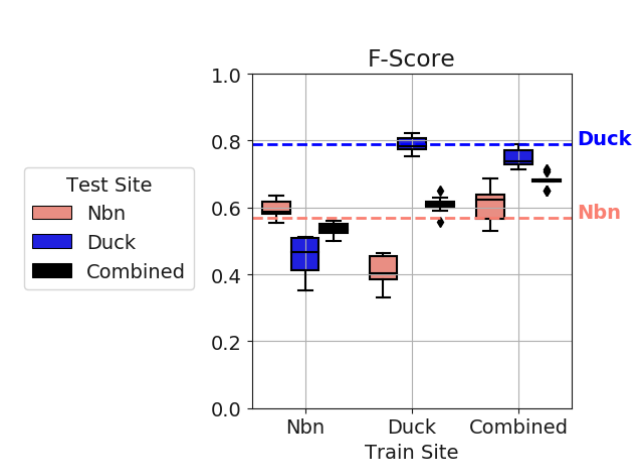
Figure 5. F-score performance values from tests at individual and combined datasets. The x-axis shows the location of training data. The boxes show the quartiles of the F-scores from the ensembles and the whiskers the rest of the distribution within 1.5 × the interquartile range. The horizontal dashed lines correspond to the inter-labeller agreement